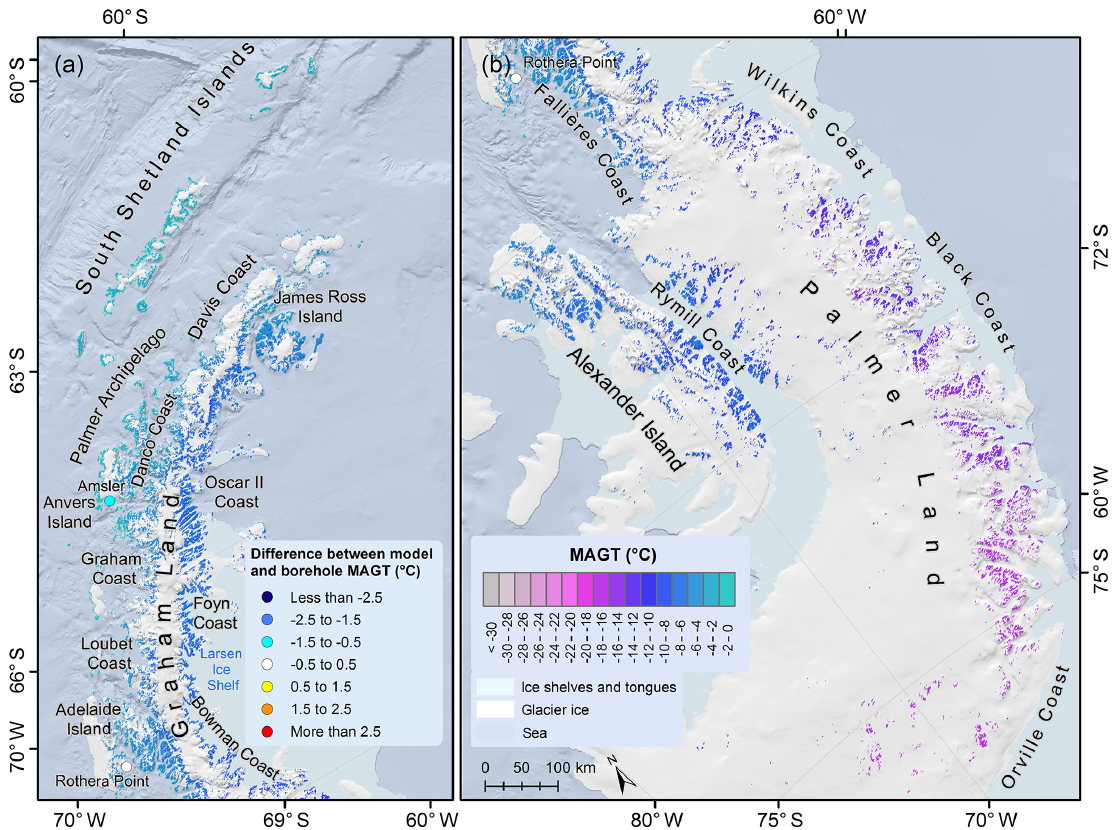
Figure 12. Permafrost temperature maps of the Antarctic Peninsula and differences between borehole and modelled MAGT. Legends, scale and north arrow are valid for both panels. See Fig. 1 for location of panels (a) and (b)